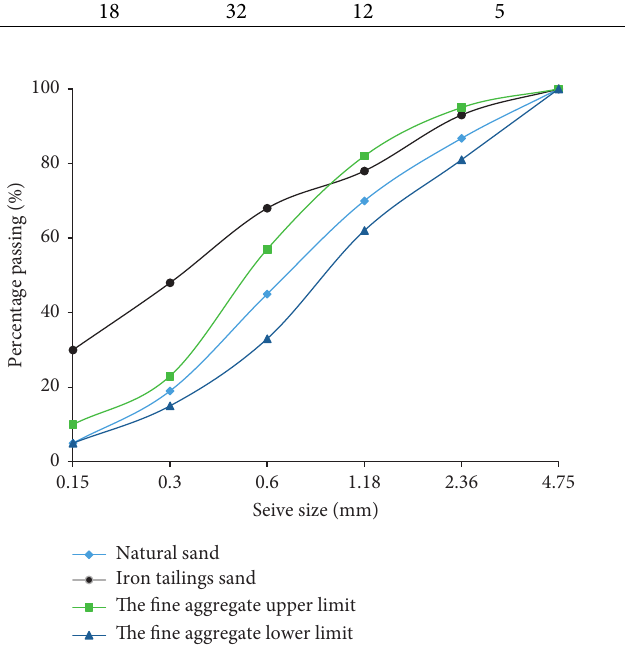
Figure 1: Grain size distribution curves of NS and ITS. Table 3: Mixture proportion of three concrete